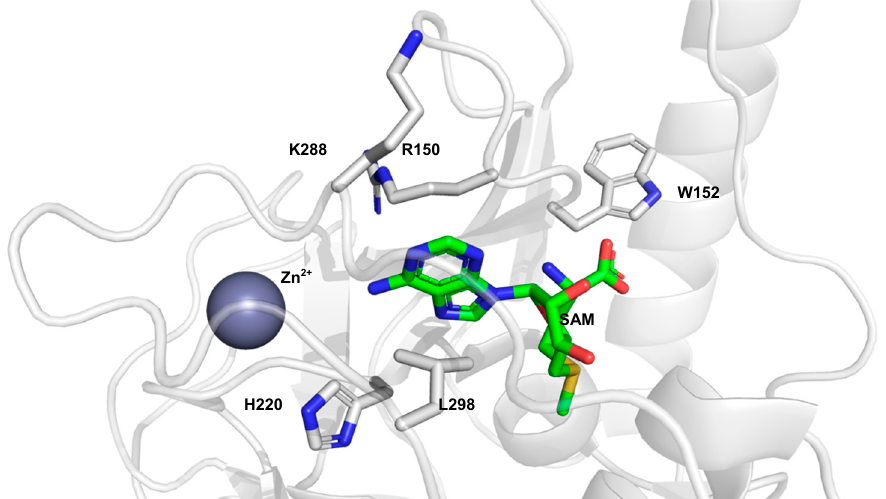
Figure 7. Ribbon representation of SUV39H2 (grey) in complex with SAM (green). Key binding site residues are labeled, and zinc ion is depicted as a sphere. SAM is stabilized via hydrogen bonding with K288, H220, and W152. R150 and L298 are involved in cation– π and hydrophobic interactions, respectively. (PDB-ID: 2R3A).